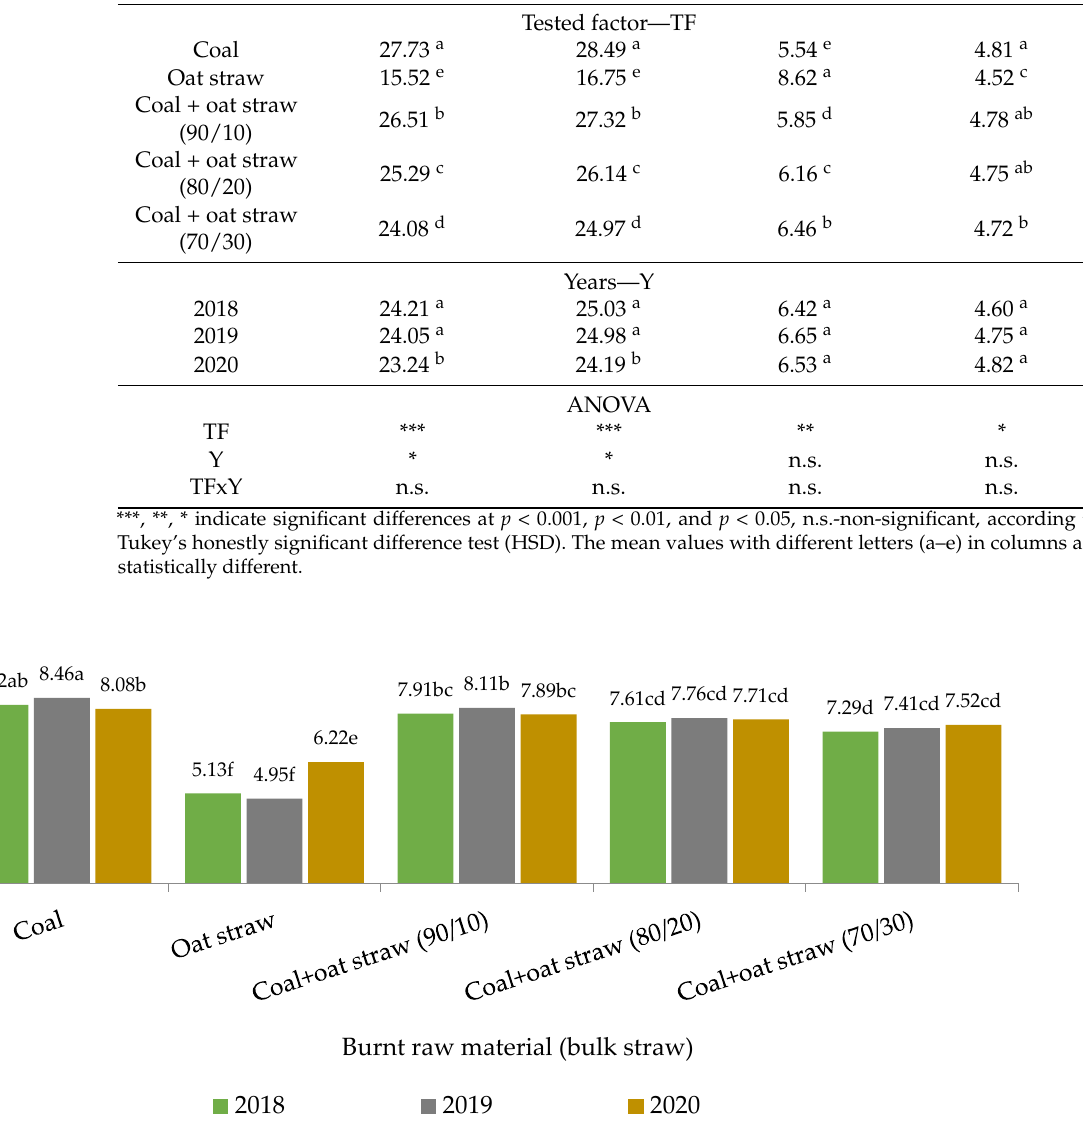
Figure 2. Ash content ( A a ) in %. Significant interaction differences at p < 0.05. Mean values with different letters (a–f) in the columns are statistically different.